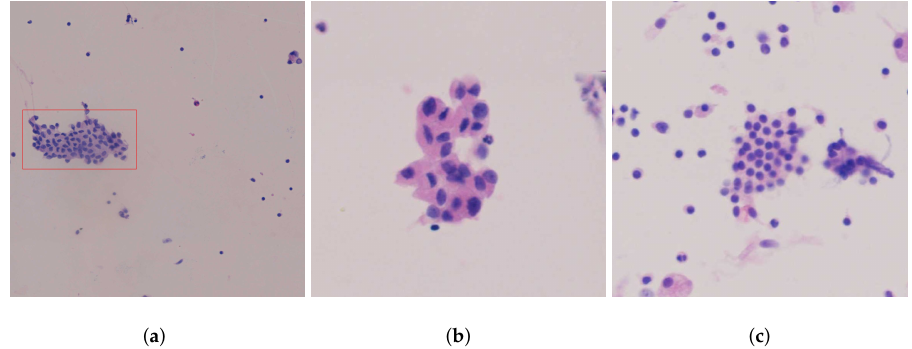
Figure 2. Examples of the datasets: ( a ) annotated image; ( b ) an image labelled as positive; ( c ) an image labelled as